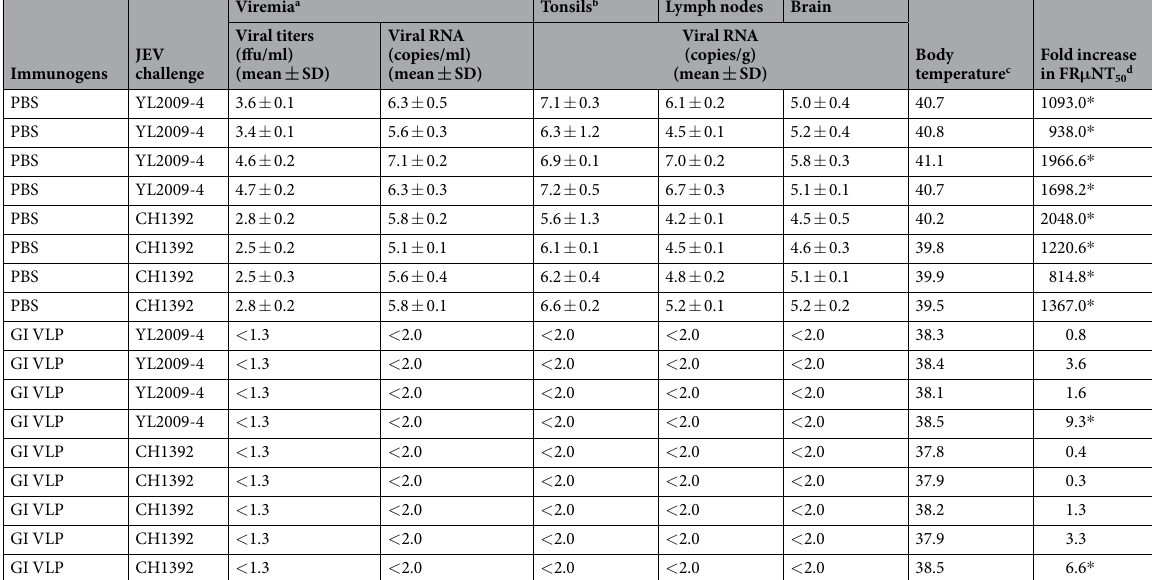
Table 2. GI JEV VLP-vaccinated pigs challenged with GI and GIII viruses. a The viral titers and viral RNA in pig plasma was detected and duplicated by micro-plaque assay and real-time RT-PCR at 2 DPI. b The viral RNA was quantified in duplicate samples of tonsils, lymph nodes, and brain from infected pig at 8 DPI by real-time RT-PCR. c The highest body temperature of swine was indicated during 8 days post-challenge. d In